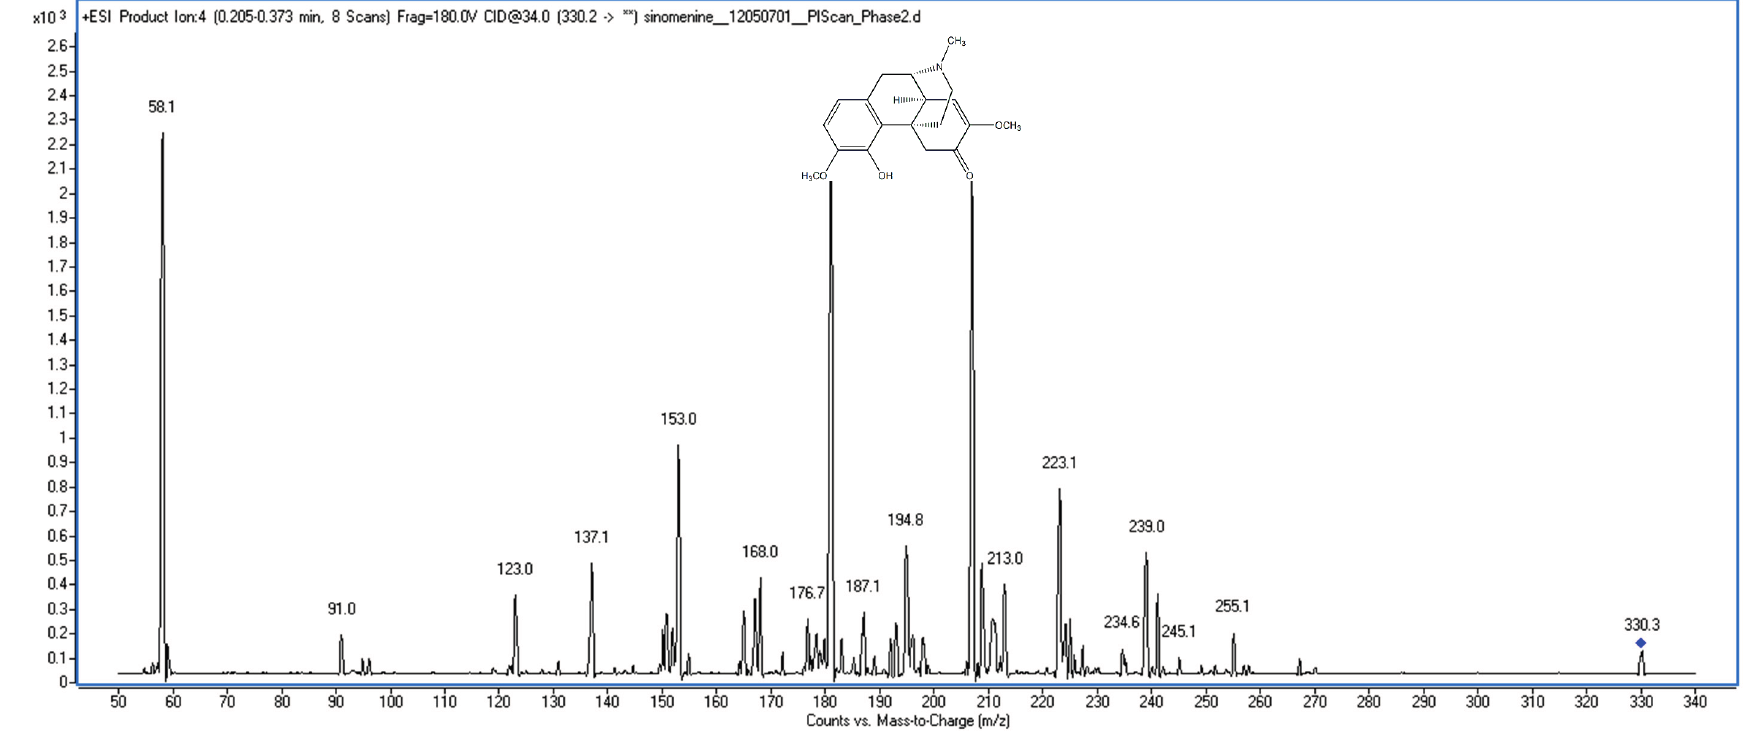
Figure 1. The chemical structure and mass spectra of